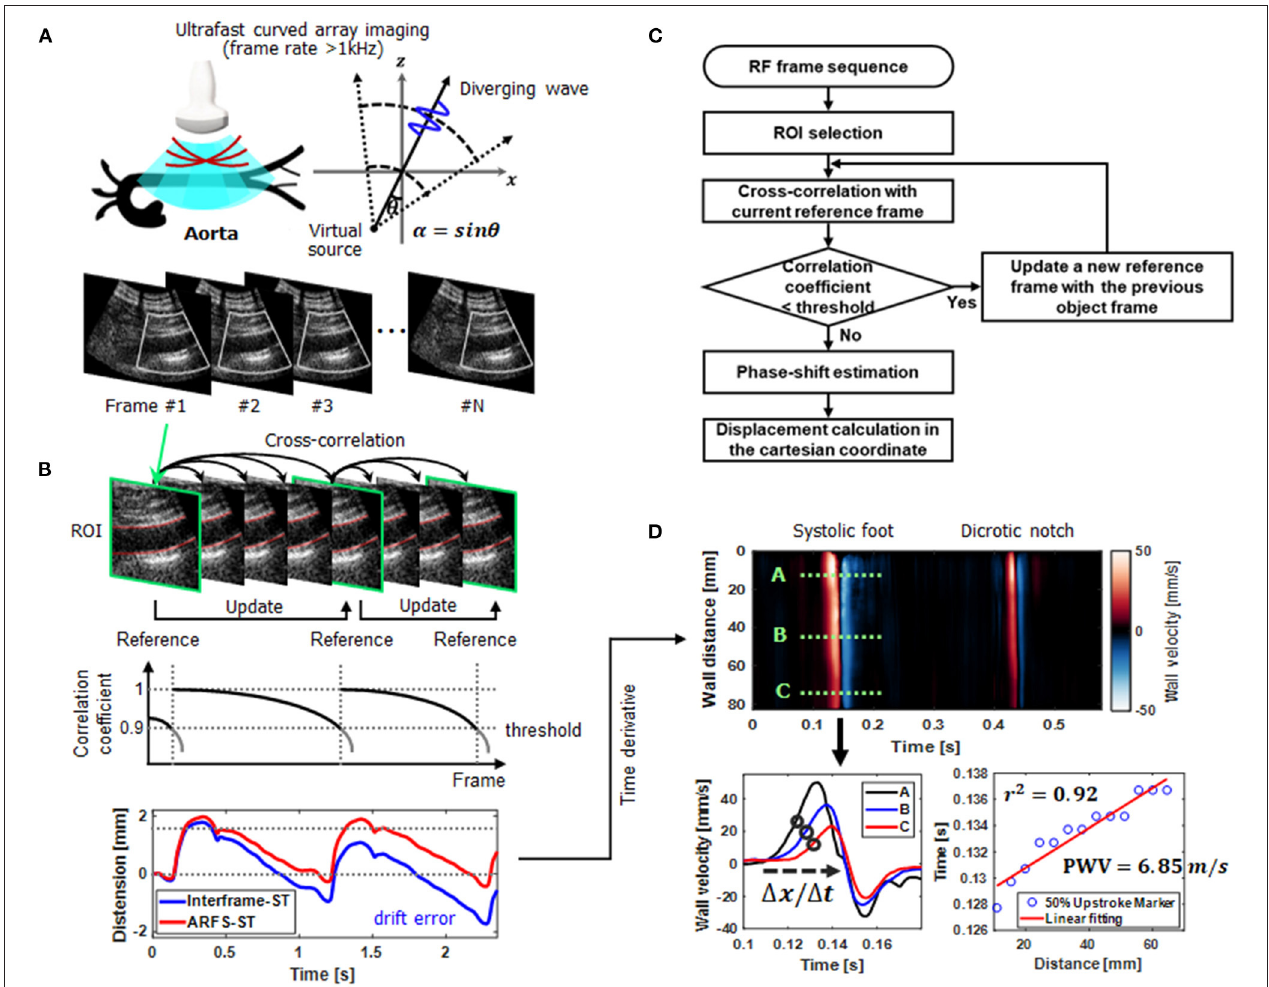
FIGURE 1 | An overall schematic representation of aortic ultrafast pulse wave velocity (PWV) assessment procedure. (A) Real-time scanning and a full scanline RF data acquisition using ultrafast curved array imaging based on diverging wave transmissions. For a diverging wave transmission, the virtual source was located in a circular line with the radius of the curved array transducer and the steering angle ( θ ). (B) Aortic wall motion tracking (speckle correlation) based on a new adaptive reference frame update (ARFD) method. By dynamically updating the reference frame in accordance with the correlation coefficient, the intrinsic error or bias (e.g., drift error) from out-of-plane motion or scanning is compensated. (C) The flow chart of the ARFD implementation. (D) Aortic ultrafast PWV (ufcPWV) imaging and calculation (PWV = 1 distance/ 1 time) based on the time-distance plot for the 50% upstroke marker of the forward